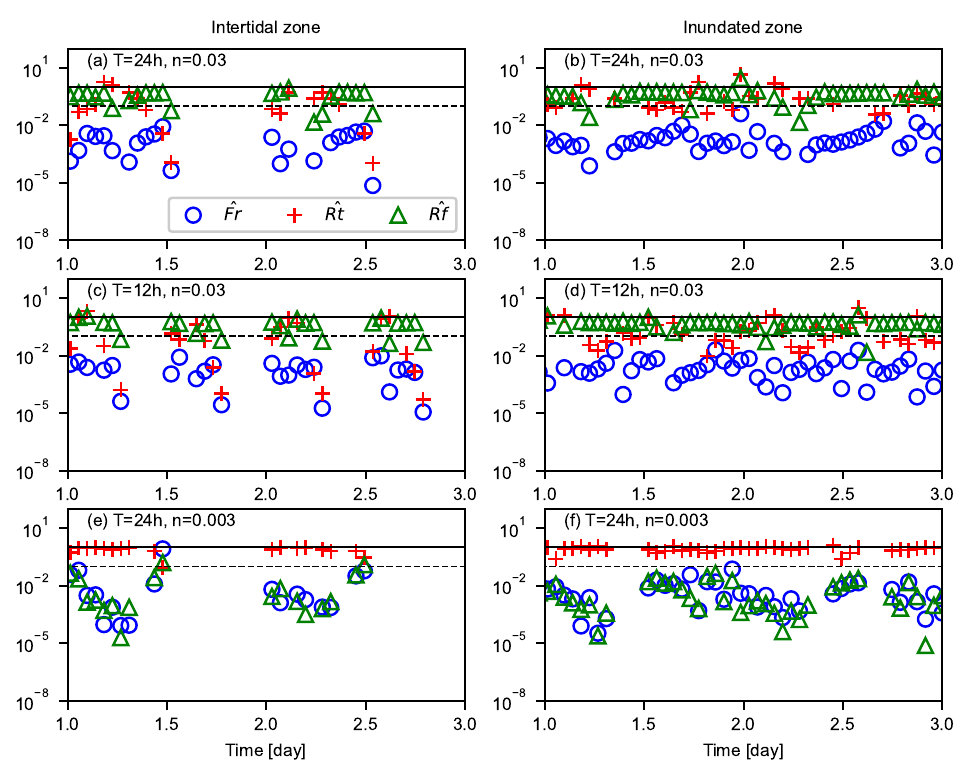
Figure 9. ˆ Fr , ˆ Rt and ˆ Rf for simulations of inundation of an intertidal zone as measured at the 1/2 location (left column) and 3/4 location (right column) noted in Figure 6. The black solid line is at 1 and the black dashed line is at